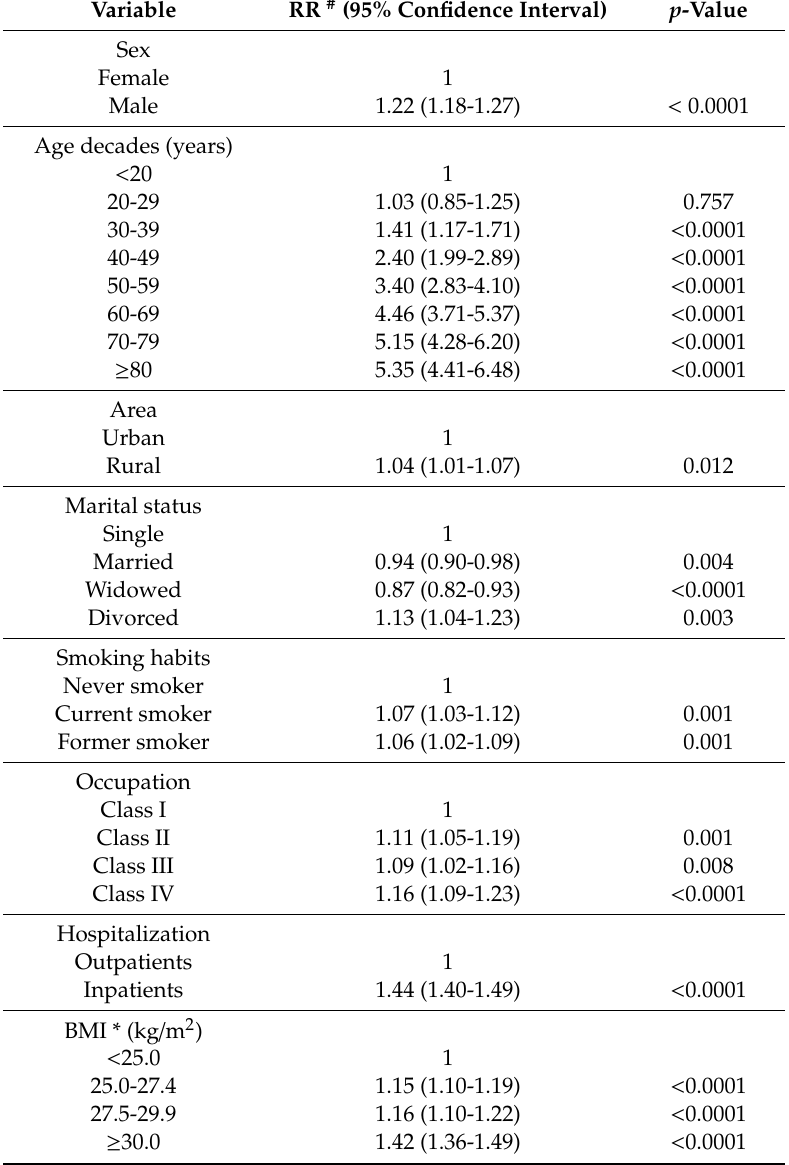
Table 3. Multivariate analysis to evaluate the association between multimorbidity and body mass index, after adjusting for potential